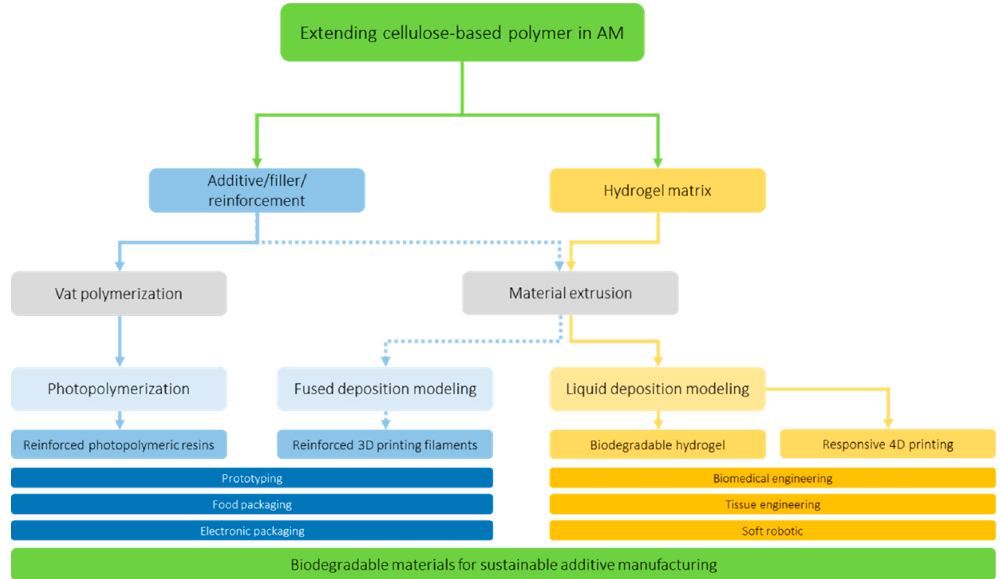
Figure 3. Possible pathway of extending cellulose-based polymer as green and biodegradable materials for sustainable additive